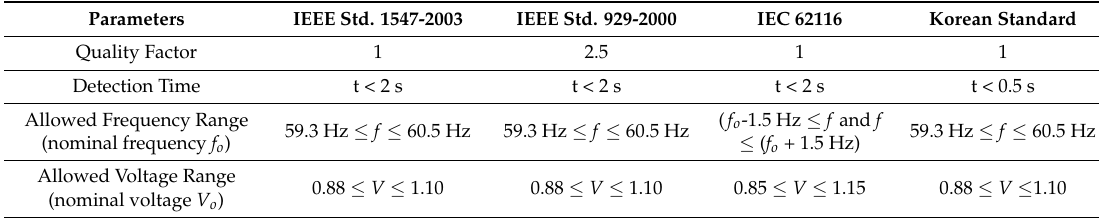
Table 2. Standards for Islanding